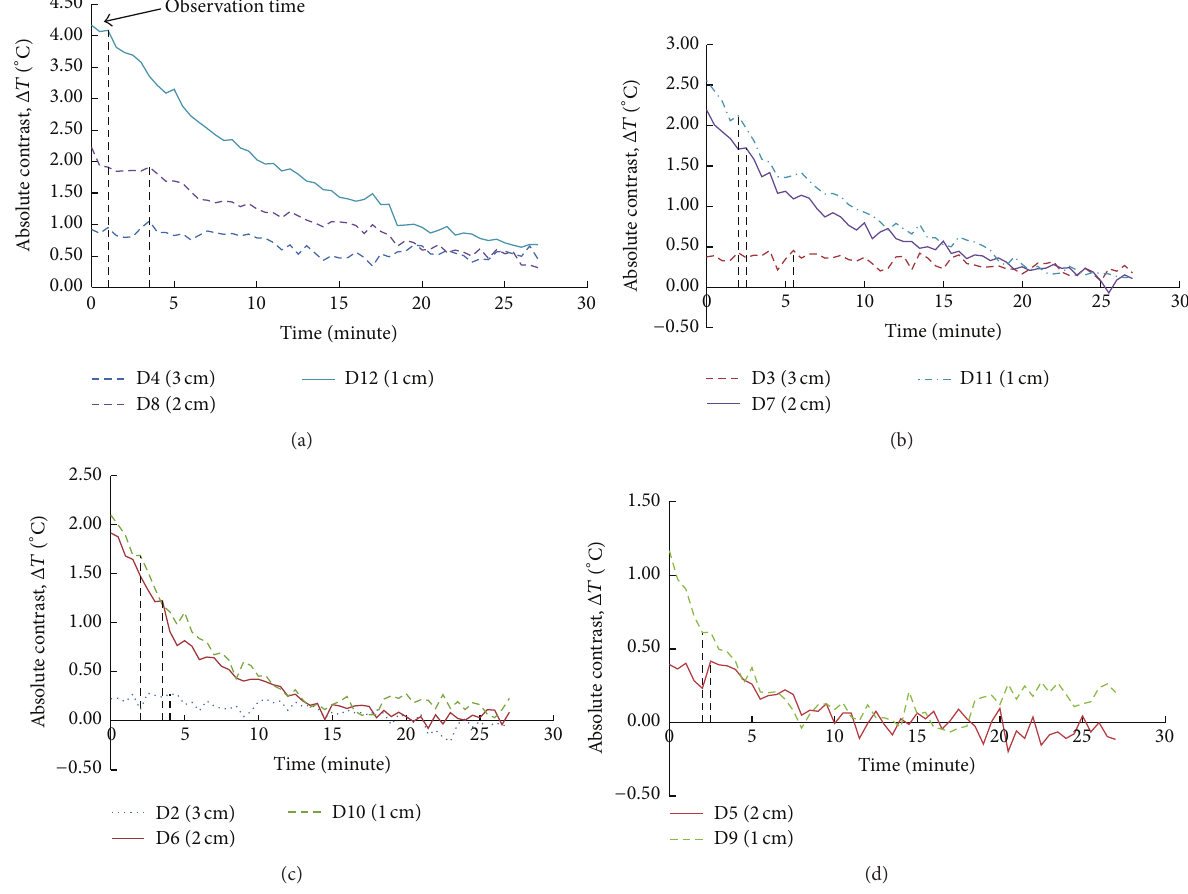
Figure 12: Absolute contrast during cooling time for the delaminations of sizes: (a) 10 × 10 cm, (b) 7 × 7 cm, (c) 5 × 5 cm, and (d) 3 × 3 cm under the 20-minute heating